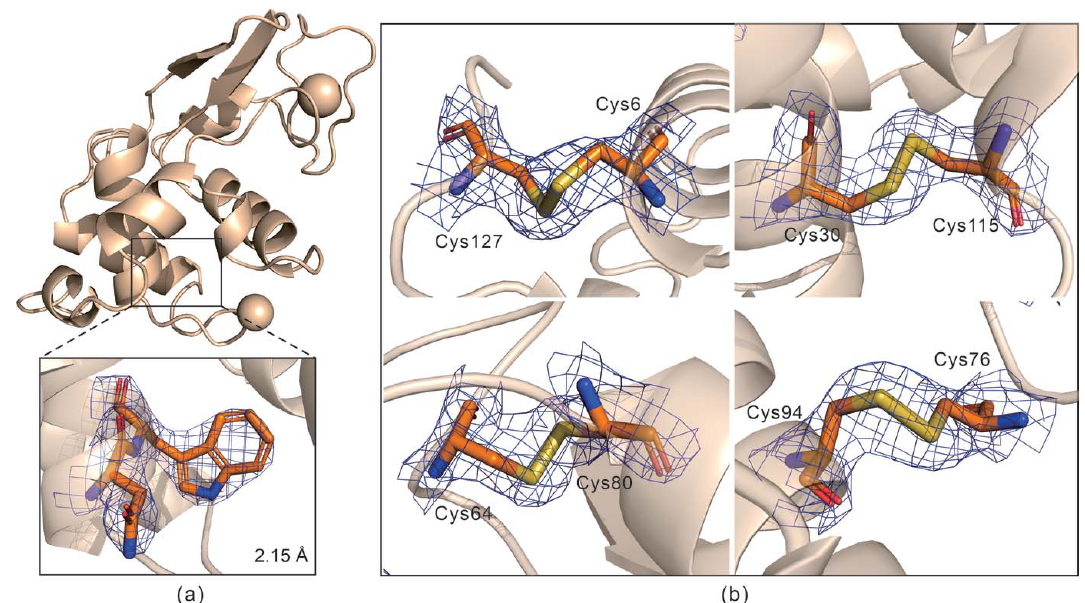
Figure 6 Structural analysis. ( a ) Lysozyme structure and the enlargement of typical residues as well as their electron density maps obtained through the data set of D1-8. ( b ) 2 F o (cid:2) F c (blue mesh, 1.5 (cid:2) ) and F o (cid:2) F c (red mesh, (cid:2) 3.0 (cid:2) ) electron density maps of the disulfide bond in lysozyme.